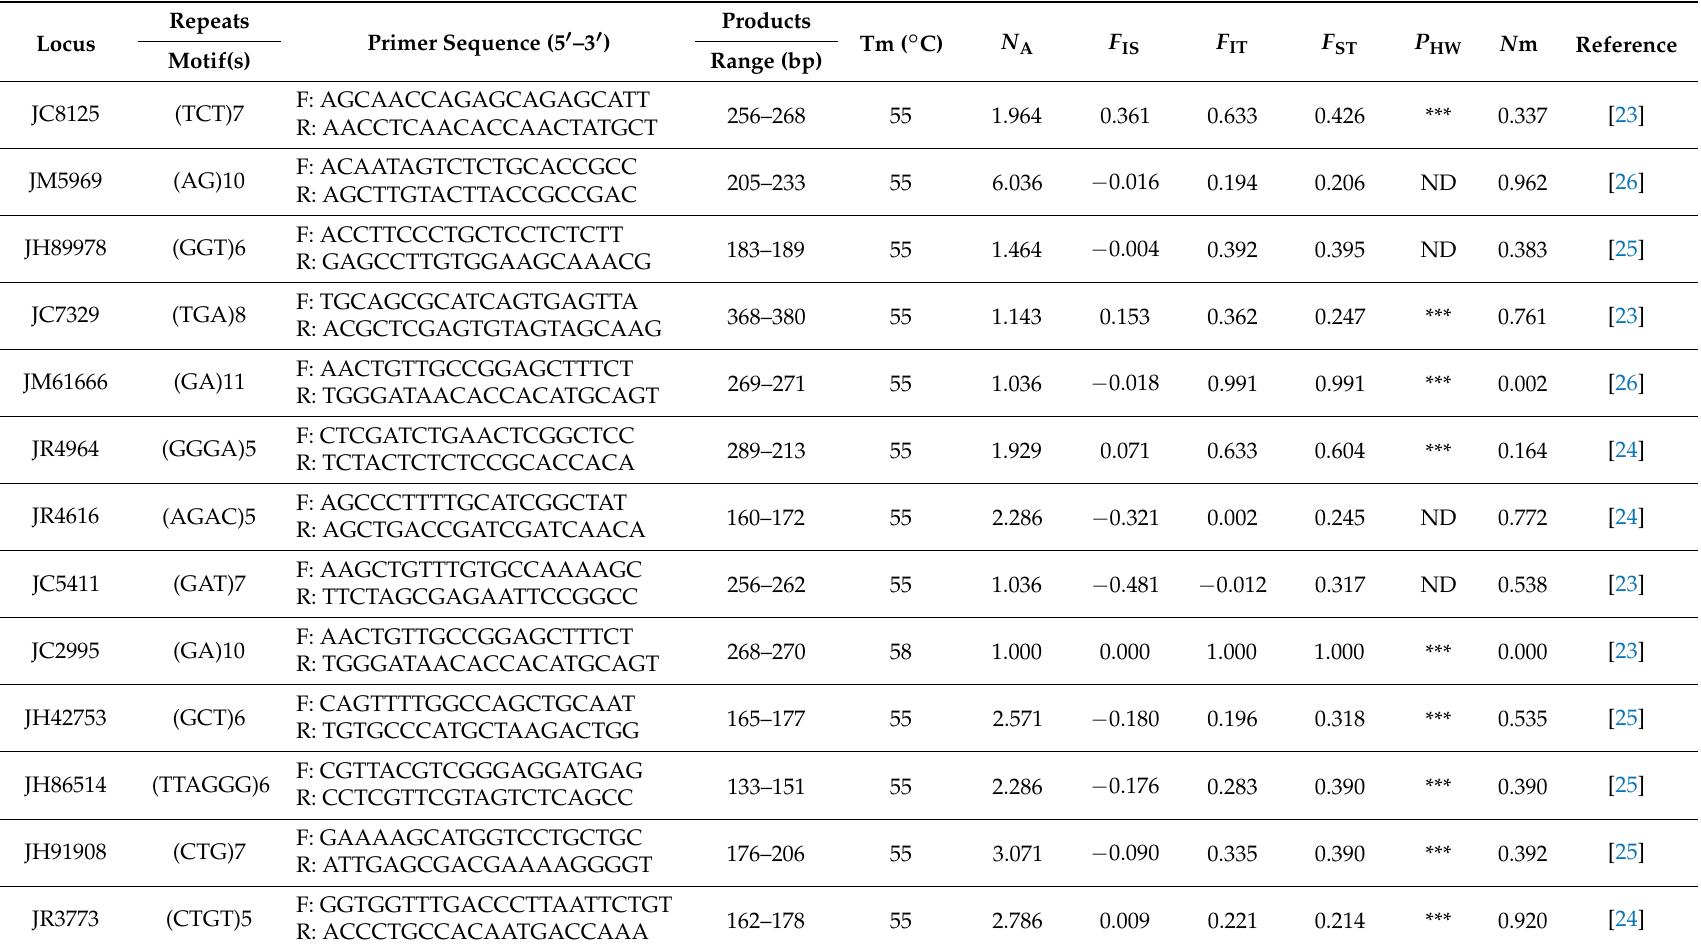
Table 1. Characterization of 25 microsatellite (EST-SSRs) loci from Juglans populations in